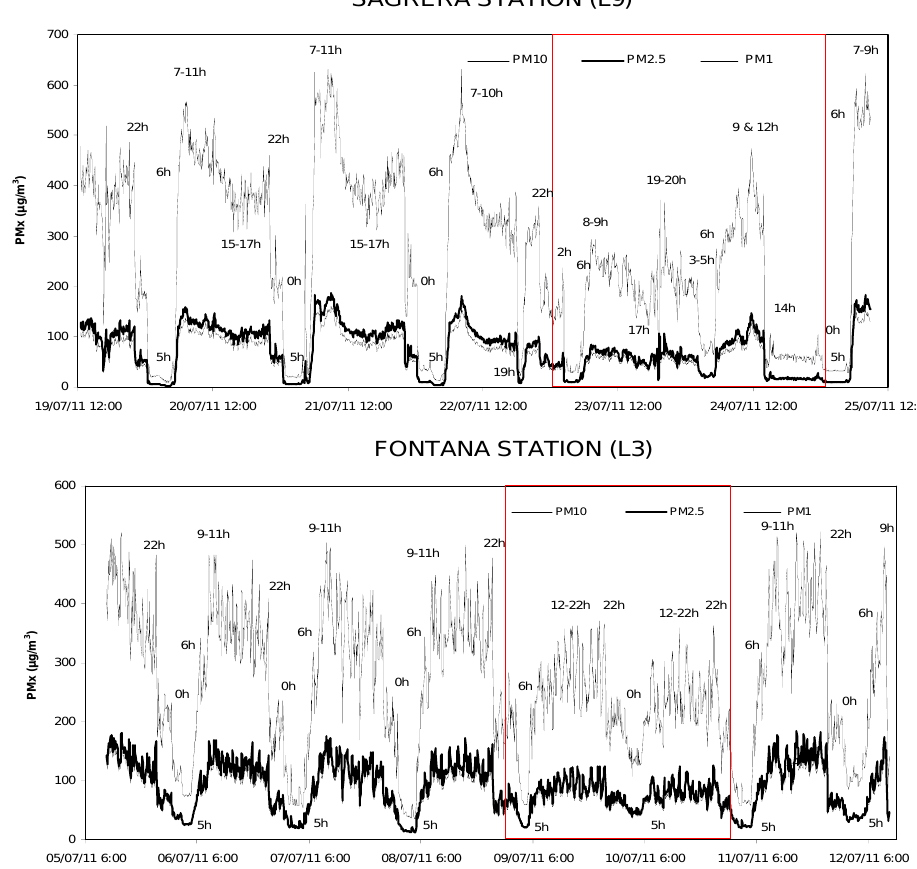
Fig. 4. Hourly PM 10 , PM 2 . 5 and PM 1 levels recorded during specific days at Fontana (F-L3) and Sagrera stations (S-L9) showing very repetitive daily trends. Red squares indicate weekends.